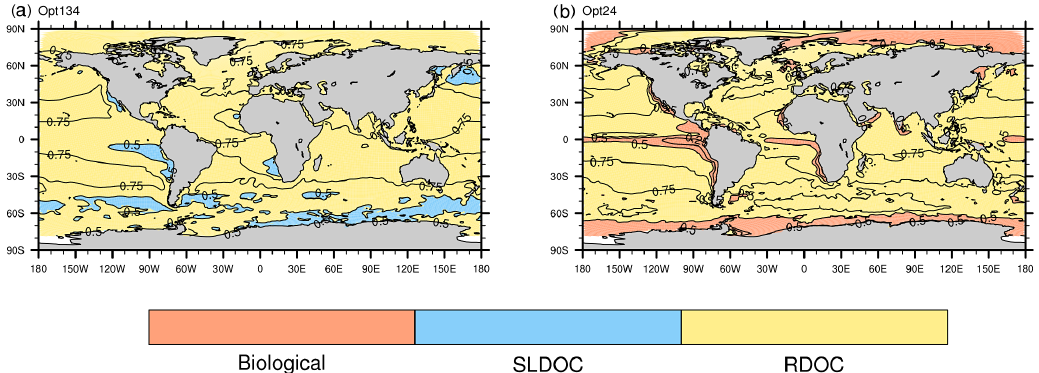
Figure 8. Source apportionment (shaded contours: local dominant source; black contour lines: fraction of photochemical production from RDOC) in the experiment with mixed biological and photochemical production, Opt134 (a) , and the one with mixed biological production considering stressed picocyanobacteria and photochemical production from RDOC, Opt24 (b)